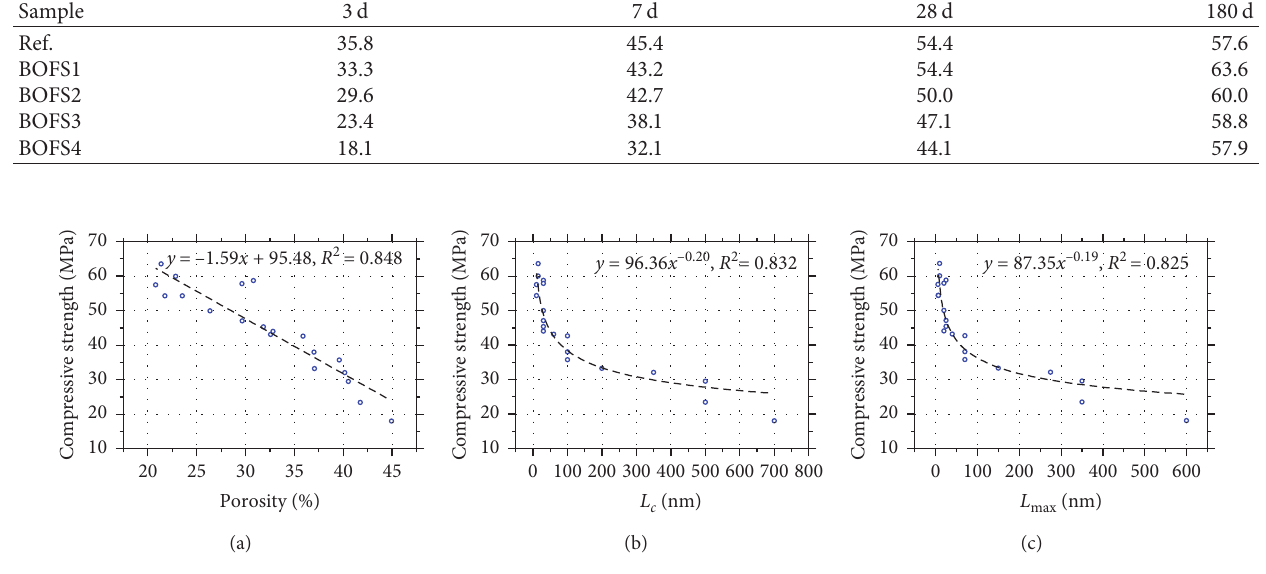
Figure 10: Correlation between compressive strength and pore structure.